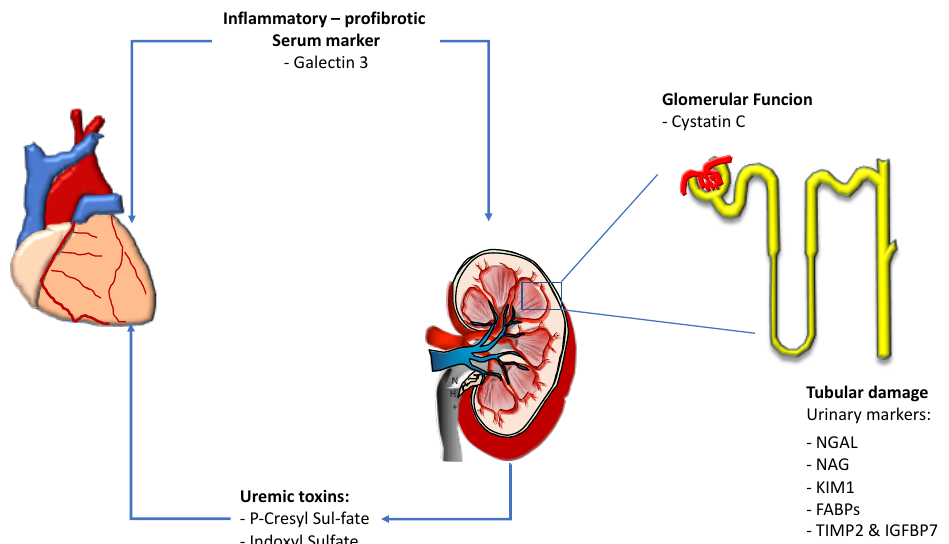
Figure 1. Main renal biomarkers indicative of cardiorenal and renocardiac syndrome progression. NGAL: N-acetyl beta